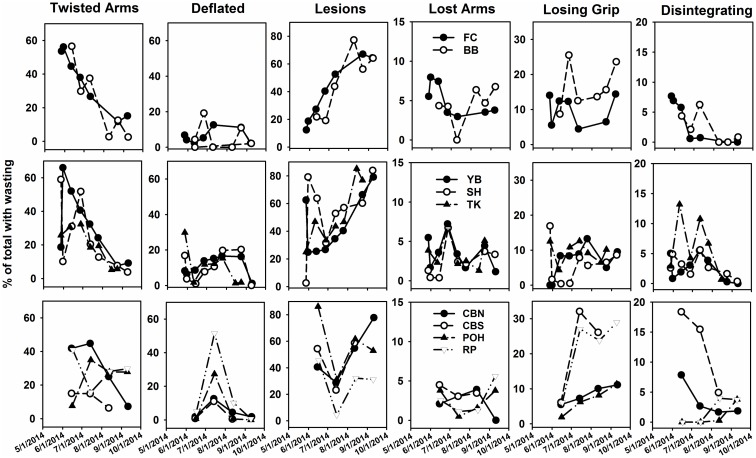
Frequencies of sea star wasting symptoms for P. ochraceus through time, summer 2014, at 9 sites.Top row = Cape Foulweather sites, middle row = Cape Perpetua sites, and bottom row = Cape Blanco sites. See Fig 1 caption for site names.